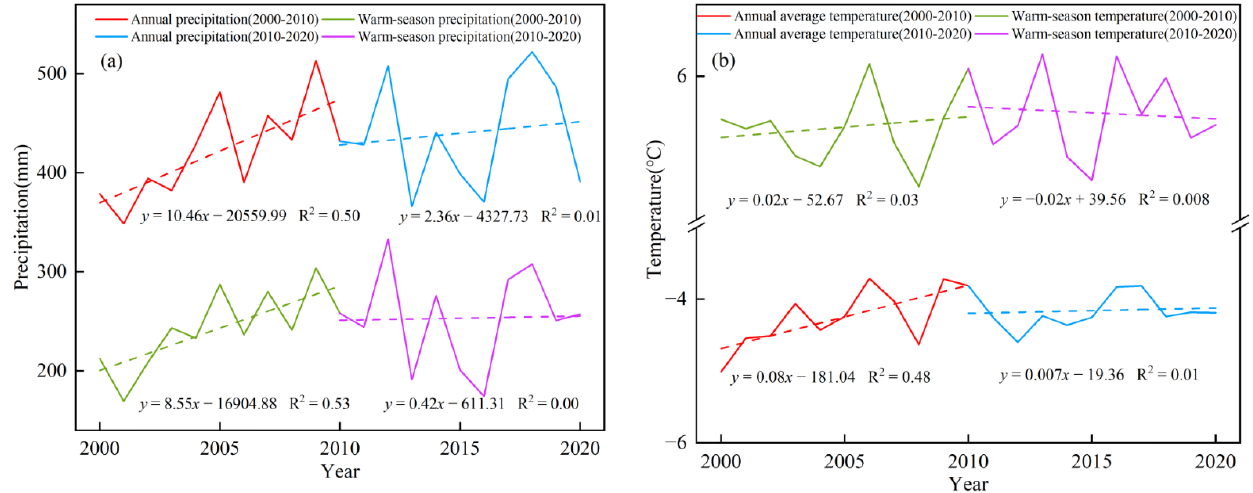
Figure 5. Variations of climate factors in the YRSNP from 2000 to 2020. ( a ) The interannual variation of annual precipitation; ( b ) the interannual variation of annual average temperature.